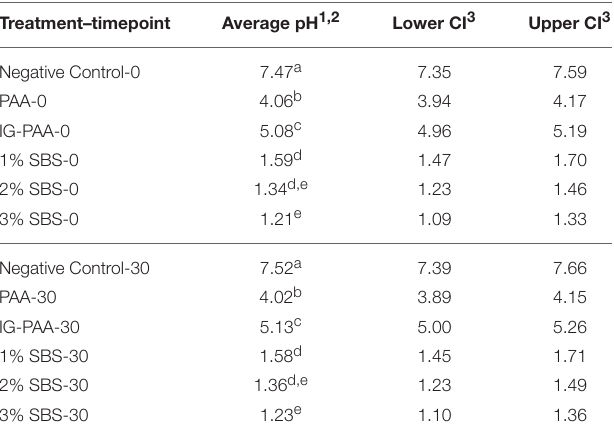
TABLE 1 | Impact of acidifiers on pH of S. Typhimurium inoculated reuse water at time point 0 and 30.